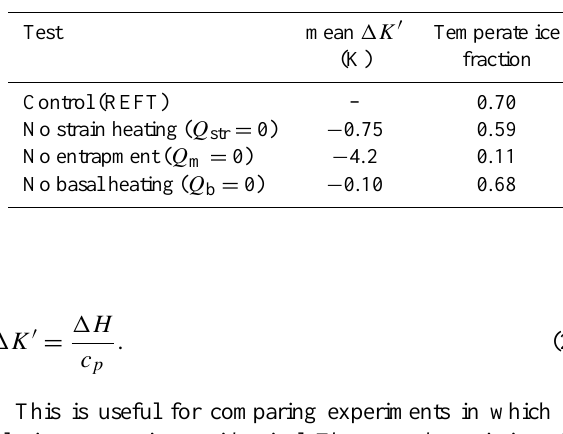
Table 3. Results of heat source removal (Experiment 1) with fixed glacier geometry and flow-law coefficient A (Eq.